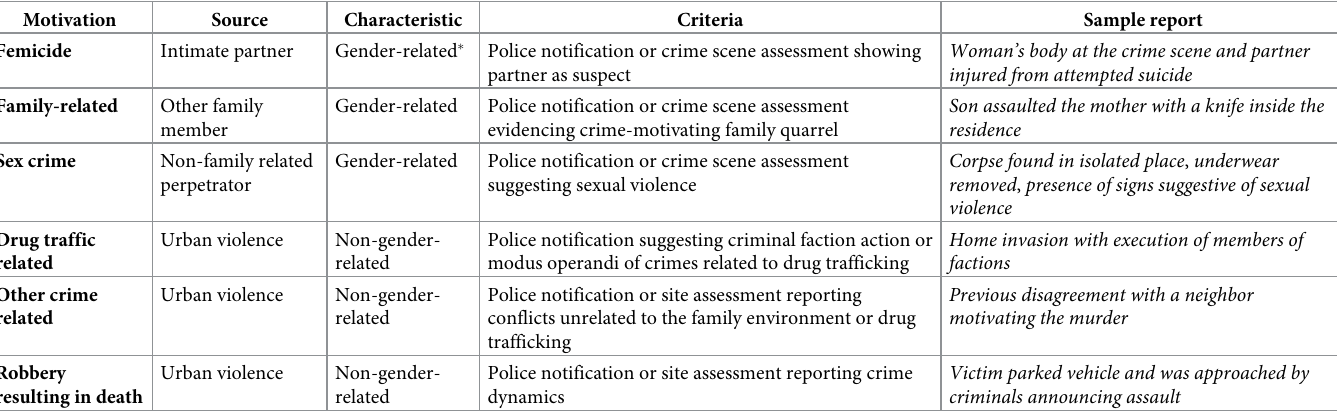
Table 1. Definitions, criteria used and examples of police reports on female